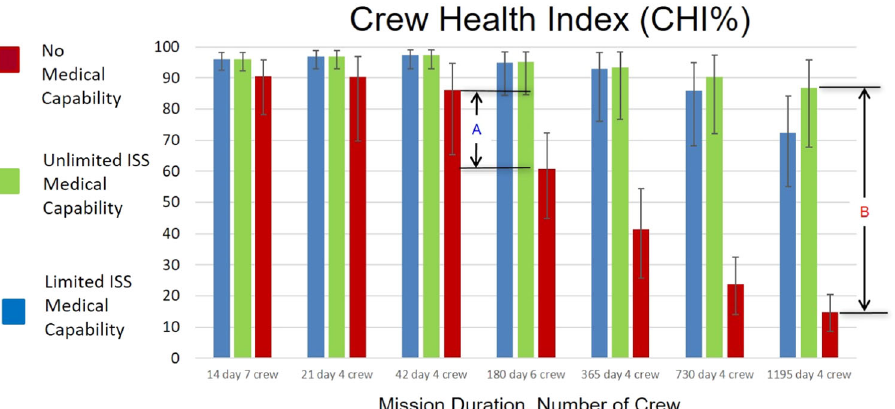
Fig. 3 Crew health index (CHI) predicted for the indicated mission duration and crew complement. 100 represents fully functional crew while 0 represents totally incapacitated crew. Parameters A and B are discussed in the text. The results are shown by DRM across the x-axis and subdivided by the level of medical capability included in each situation. The 95% CIs is interpreted as the uncertainty estimated with respect to the data informing the 100 medical conditions and the PRA abstraction of the medical event timeline and end-states. As unaccounted uncertainties are not represented in this formulation or data representation, outcomes should be considered as representative of relative changes in risk rather than absolute risk assessments 14 . ISS International Space Station.